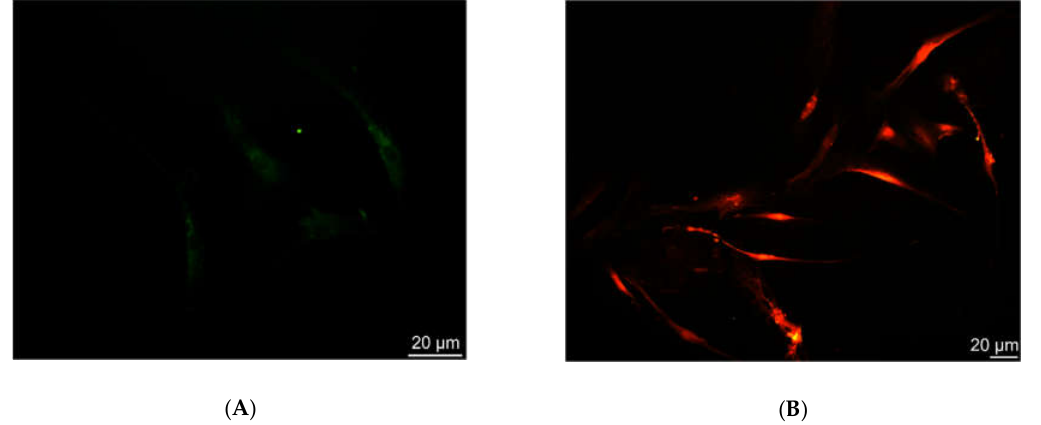
Figure 3. Uptake of Ru(bpy) 32+ in human dermal fibroblast after 24 h labeling, observed by fluorescence microscopy: ( A ) green intrinsic auto-fluorescence of HDFs control; ( B ) red fluorescence of HDFs induced by 0.4 µ M Ru(bpy) 32+ , with a high density in the central region. Fluorescence was acquired with a 488 nm light source and collected at 620–630 nm.